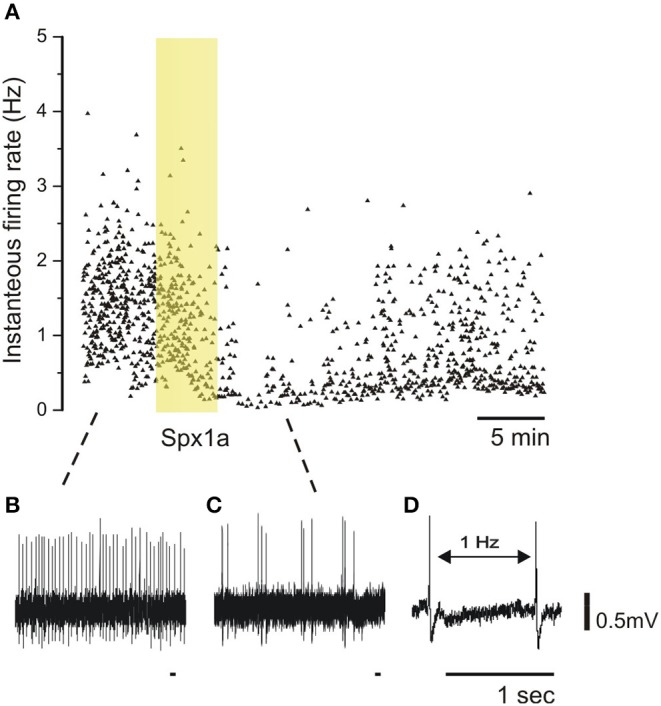
Effect of spexin1a on firing rate of LH cells in mature tilapia. Transgenic tilapia (LH-RFP) pituitaries were dissected for electrophysiological recording, and a cell-attached configuration was used to monitor action potentials without breaking the cell membrane. The pituitary slice was briefly exposed to Spx1a during the recording (yellow box). (A) A graphic representation of firing-rate before (B), during (C), and after spexin application. Each dot represents an action potential along the time scale (X-axis) and the instantaneous frequency from the action potential before (Y-axis). Note that the firing-rate decreased after Spx1a was applied, and after a few minutes the spike rate slowly rises back to the control level. (D) Two spikes with an example of the firing-rate measurement.